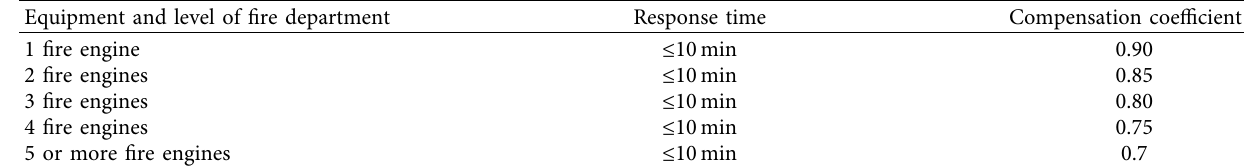
Table 6: Value-taking standard of emergency rescue team compensation coefficient τ .